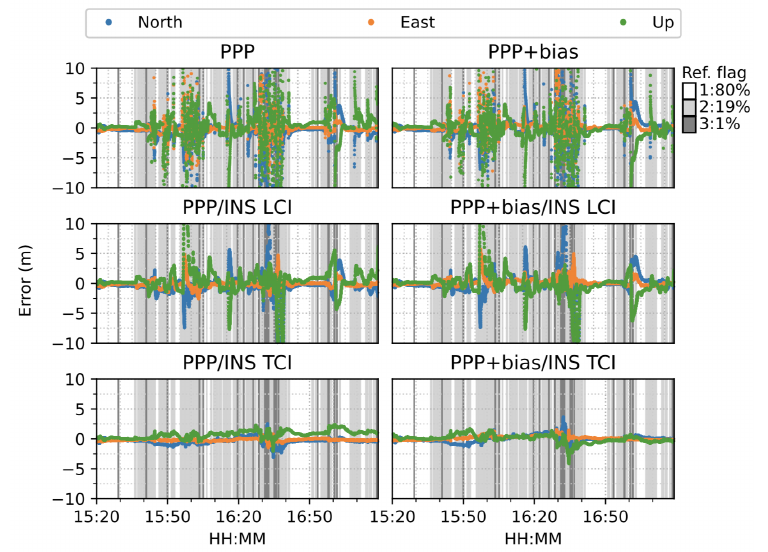
Figure 28. Real-time GPS/Galileo PPP/INS results of city center test on 27 January 2022 with respect to IE RTK/INS TCI solutions.